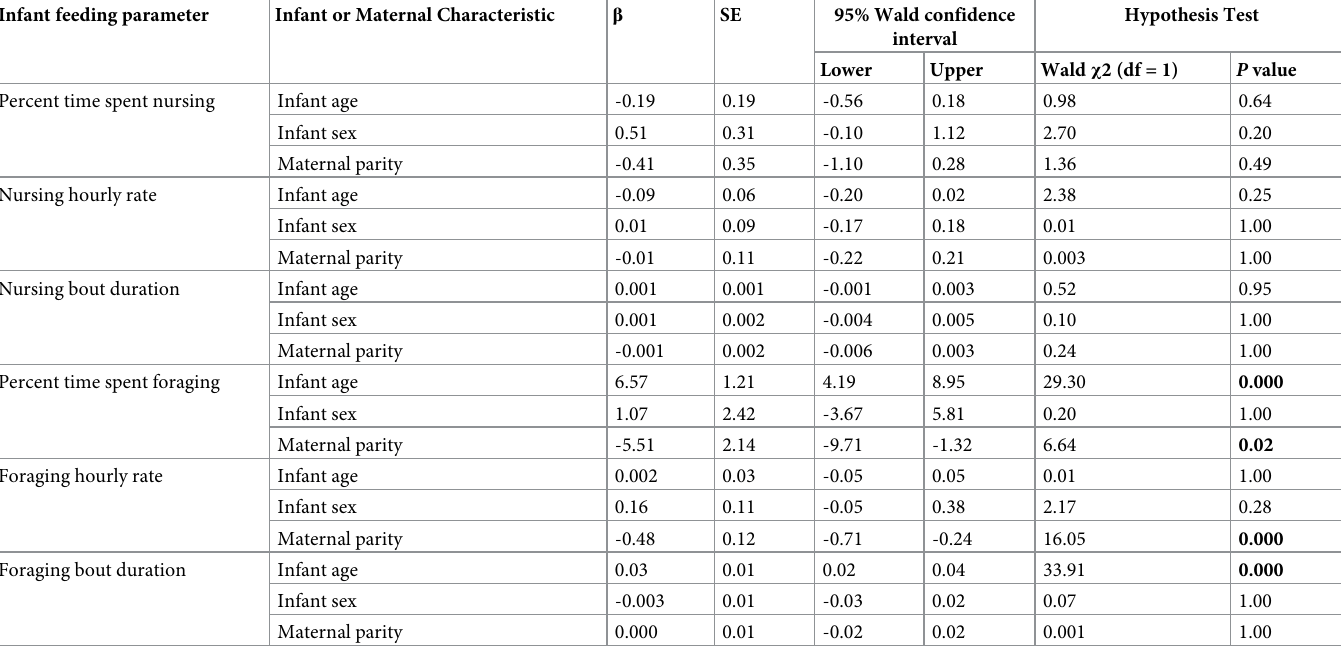
Table 3. Generalized Estimating Equations (GEEs) for correlations between feeding parameters of chimpanzees 6 months to 5 years old and infant age, sex, and maternal